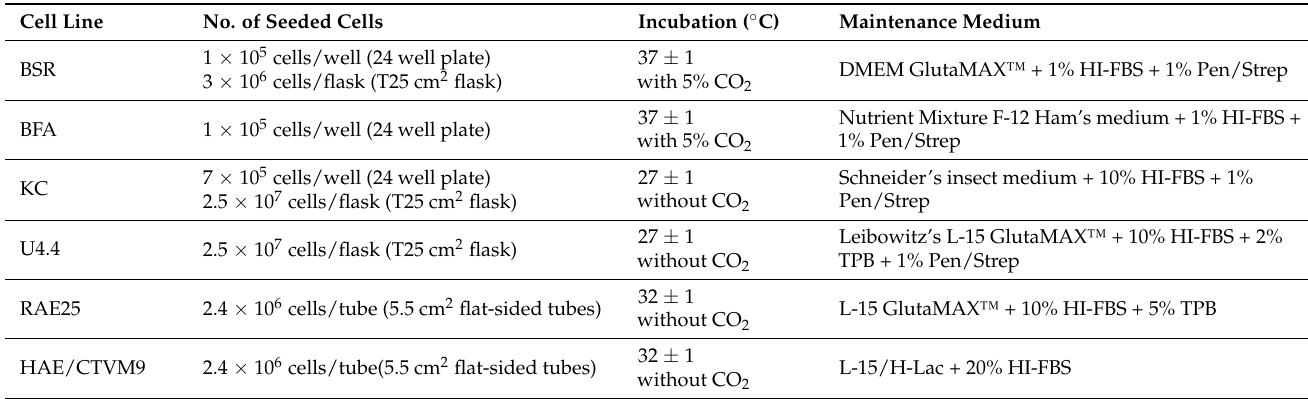
Table 2. Cell culture conditions during virus